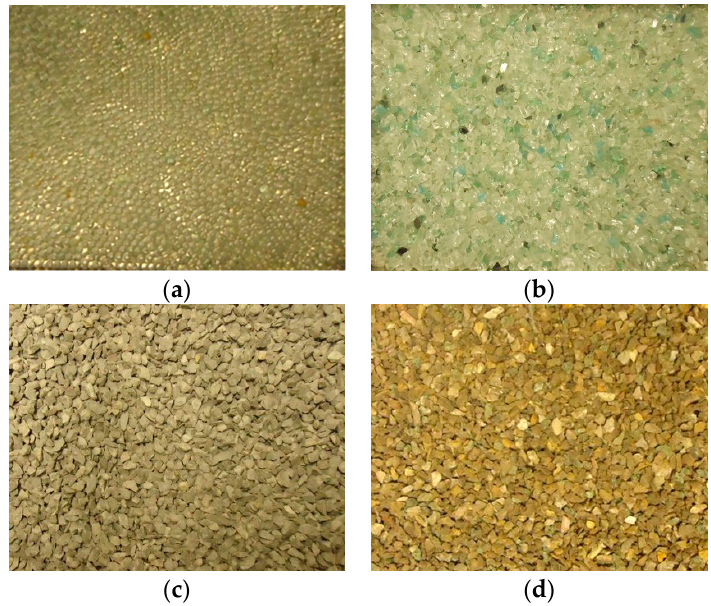
Figure 2. Photographs of the different packing materials: ( a ) glass beads (GB: 2 mm), ( b ) glass shards (GS: 4.8–5.6 mm), ( c ) greywacke (GW: 4.8–5.6 mm), and ( d ) malachite ore (MO: 4.8–5.6 mm).